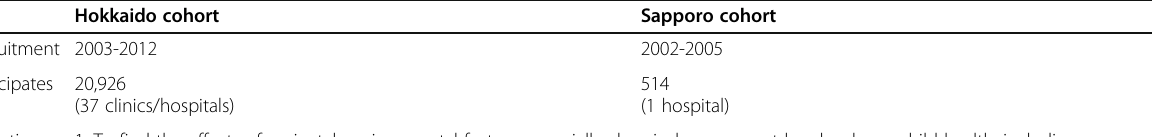
Table 1 Summary of the birth cohort